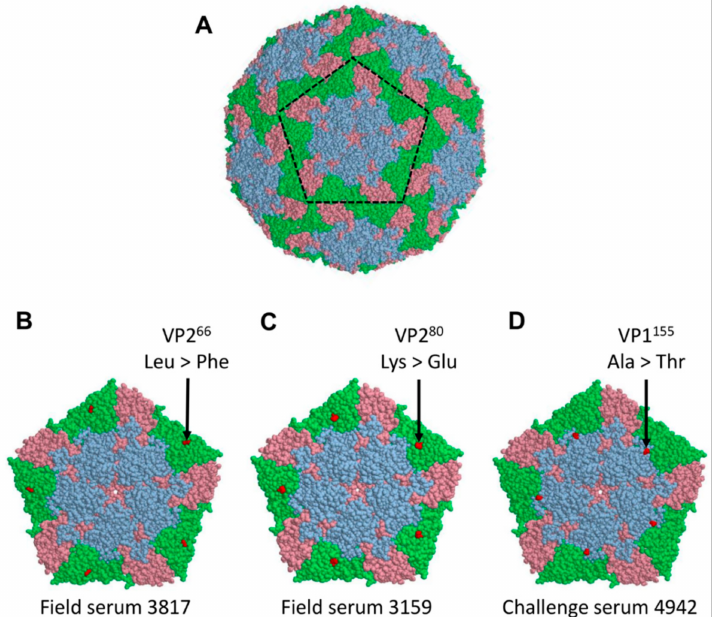
Figure 4. Surface-exposed non-synonymous mutations. The mutations that became fixed at consensus level in the viral populations passaged in the presence of sera from the Field and Challenge groups (but not identified within the starting inoculum or viruses passaged in the presence of the Control sera) were mapped onto the crystal structure of recombinant FMDV A22-H2093F empty capsid. Surface representation of the FMDV capsid ( A ). Individual pentamers enlarged to show mutations identified in the viral population passaged in the presence of Field Serum 3817, Field Serum 3159, and Challenge Serum 4942, respectively ( B – D ). The VP2, VP3, and VP1 proteins are highlighted in green, pink, and blue, respectively. Mutations are shown in